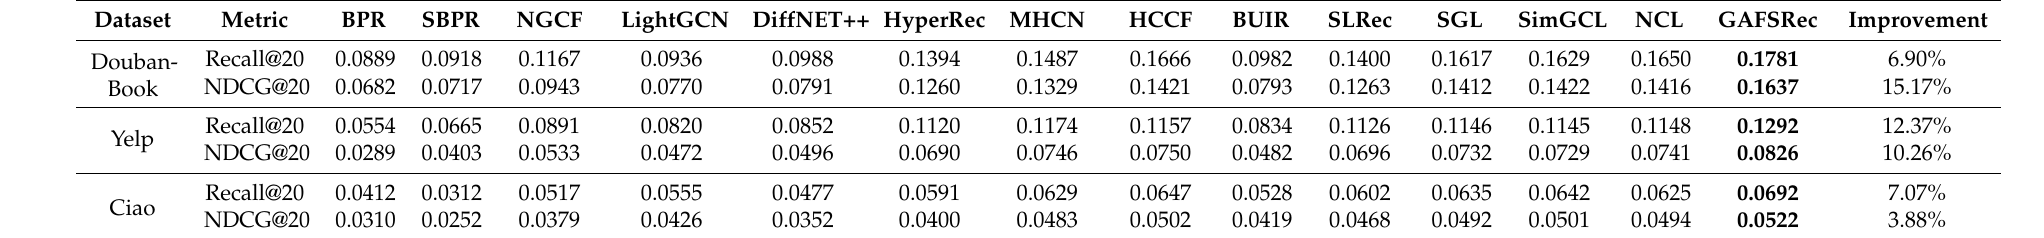
Table 3. General recommendation performance comparison.